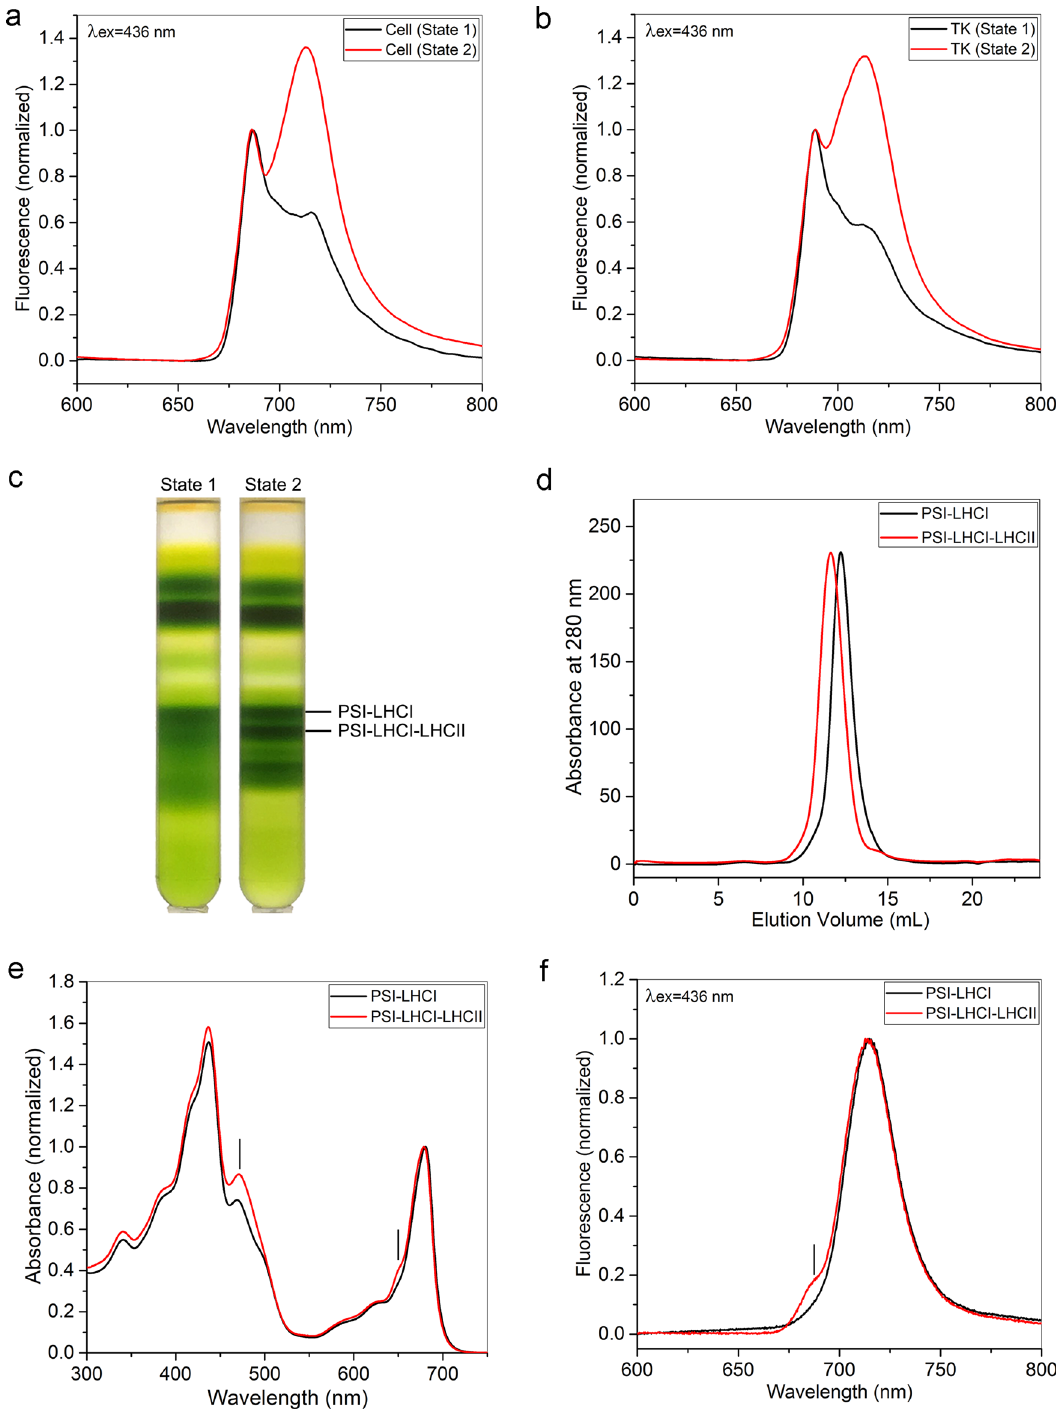
Fig. 1 Sample preparation and characterization of the PSI-LHCI-LHCII supercomplex from C. reinhardtii . a , b Low temperature (77 K) fl uorescence emission spectra of C. reinhardtii cell ( a ) and thylakoid ( b ) locked in state 1 (black line) and state 2 (red line). The excitation wavelength was 436 nm and all spectra were normalized to the emission value at 688 nm. c Separation of PSI-LHCI-LHCII supercomplex by sucrose density gradient (SDG) centrifugation from cells in state 1 and state 2. d Size-exclusion chromatographic elution pro fi les of the PSI-LHCI and PSI-LHCI-LHCII fractions isolated by SDG from the state 2 cell. Elution was performed with a Superose 6 Increase 10/300 GL column ( fl ow rate of 100 μ l min − 1 ) at 4 °C and monitored by absorption at 280 nm. e Room-temperature absorption spectra of the PSI-LHCI and PSI-LHCI-LHCII obtained from size-exclusion chromatography. The spectra were normalized to the maximum in the red region. The PSI-LHCI-LHCII supercomplex showed higher peaks at 470 nm and 650 nm (indicated by bars), indicating that this fraction contains higher Chl b content (from LHCII) than the PSI-LHCI complex. f Low temperature (77 K) fl uorescence emission spectra of PSI-LHCI and PSI-LHCI-LHCII after size-exclusion chromatography upon excitation of Chl a at 436 nm. The spectra are normalized to the maximum of the emission peaks. Both two samples show the typical emission peaks of PSI-LHCI in red region, but the PSI-LHCI-LHCII has a small shoulder at 680 nm (indicated by bar).